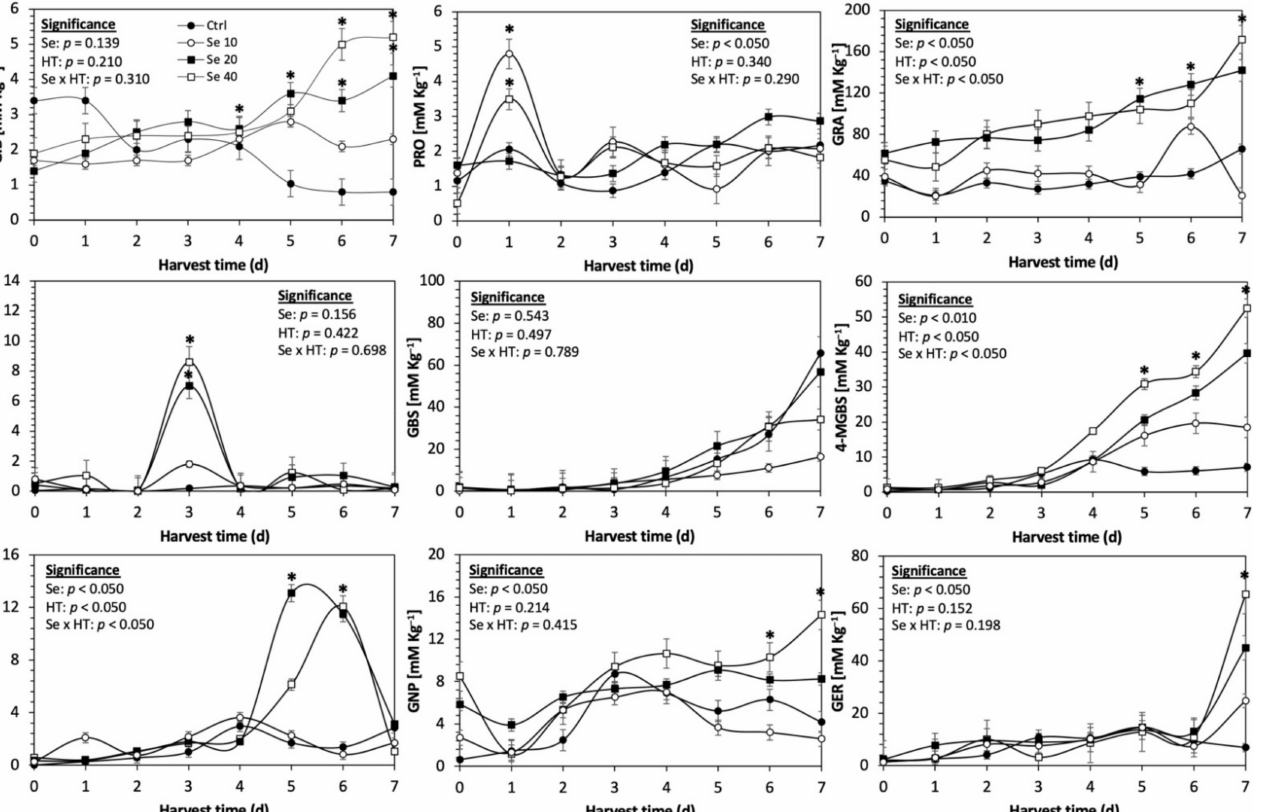
Figure 7. Concentration of individual glucosinolates in untreated Dwarf Green kale sprouts and treated with selenium during the first 7 days of germination. Bars are means of 3 replicates ± standard error. Data points with an asterisk (*) indicate statistical difference determined by a t -test ( p < 0.050) between the control and treated samples. Abbreviations: selenium (Se), harvest time (HT), glucoiberin (GIB), progoitrin (PRO), glucoraphanin (GRA), 4-hydroxy-glucobrassicin (4-HGB), glucobrassicin (GBS), 4-methoxy-glucobrassicin (4-MGBS), glucoeurocin (GER), gluconapin (GNP), and neoglucobrassicin (NGBS). Results are expressed as desulfogucoraphanin equivalents in dry weight